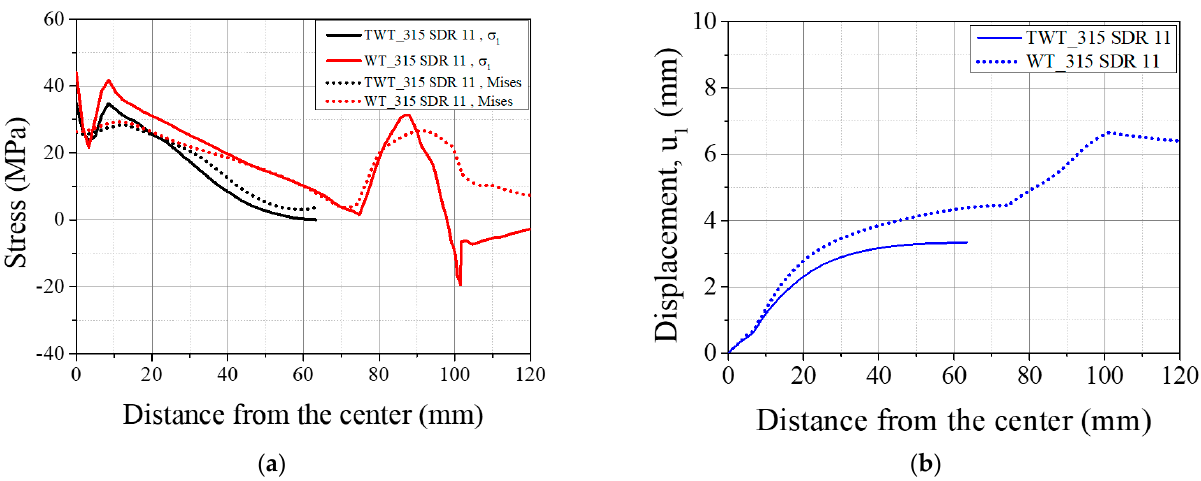
Figure 17. FEA results of Type B, 315 SDR 11 TWT and WT specimens at F max : ( a ) σ v and σ 1 ; ( b ) u 1 .